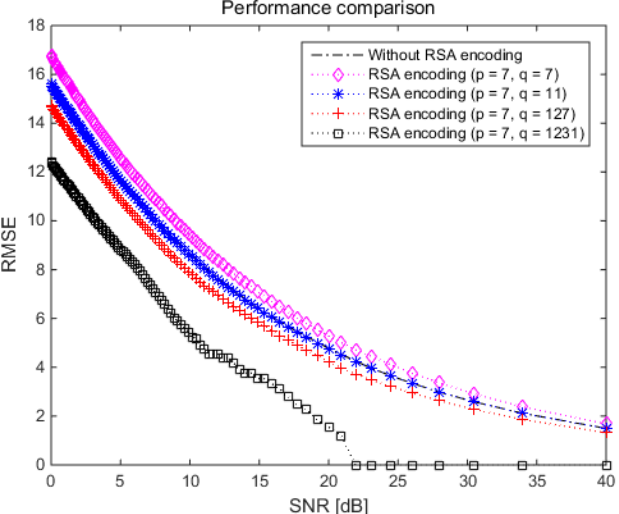
Figure 8. Root mean square error (RMSE) performance depending on various q prime numbers in proposed VL communication technique based on asymmetric encryption scheme. Table 2. Public and private RSA key sets generated by various 𝑞 prime numbers.